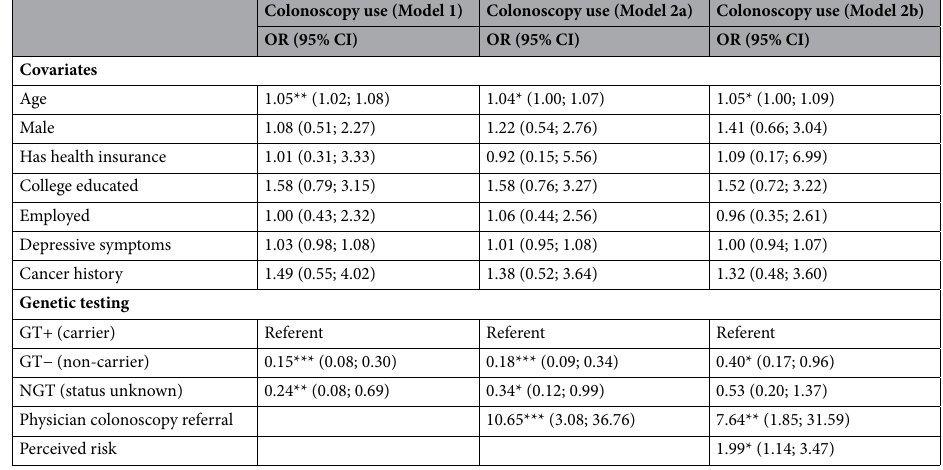
Table 2. Multivariate logistic regression, predicting colonoscopy use within 2-years of assessment (n = 176). Generalized estimating equations, with exchangeable covariance. * p < 0.05; ** p < 0.01; *** p <